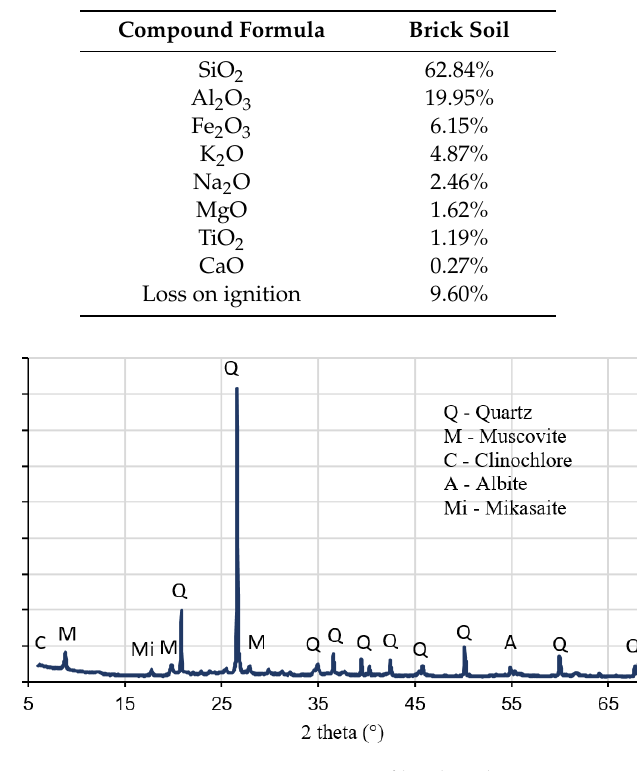
Figure 4. XRD patterns of brick soil.